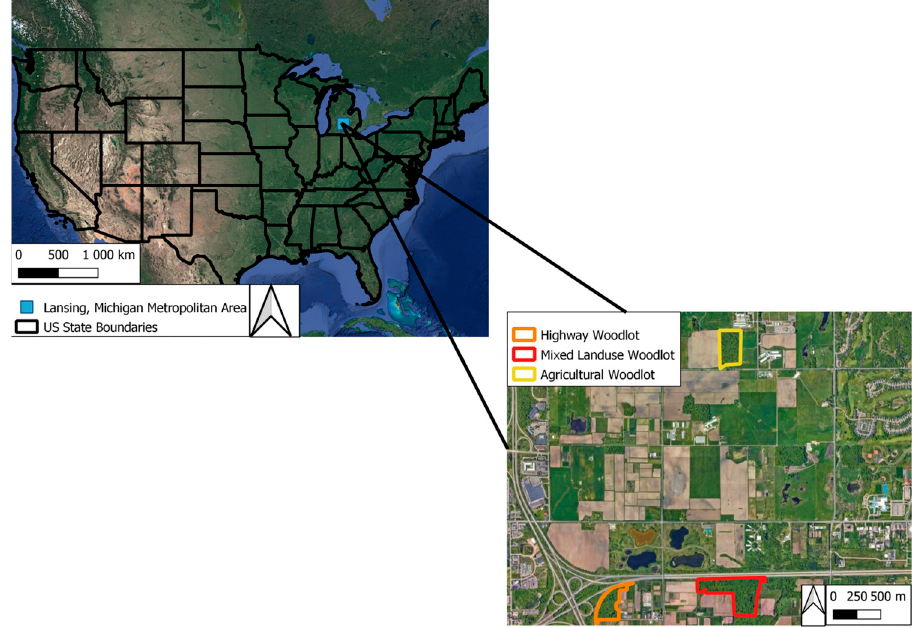
Figure 1. Study Figure 1. Study Area. Table 1. Overstory species composition and structure of the three woodlots. Data are for all trees ≥ 10 cm dbh. Relative density is the percentage contribution of each species to total trees per hectare, whereas relative dominance is the percentage contribution of each species to the total stand basal area.